Question: Summarize what this figure shows in one sentence.
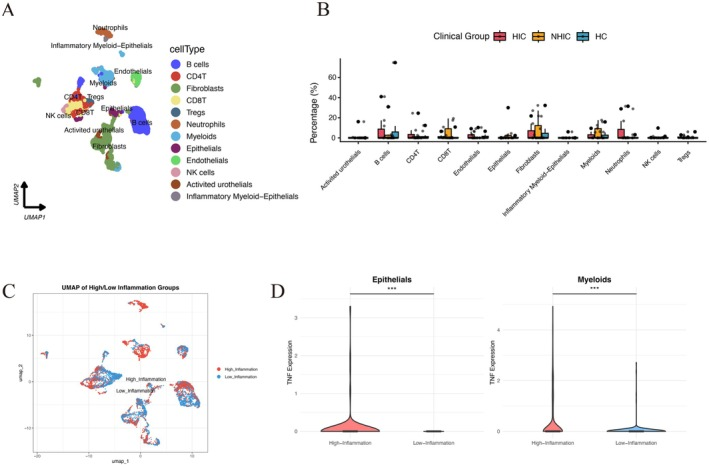
Answer: Single‐cell transcriptomic profiling of bladder tissues identifies distinct inflammatory cell states in IC/BPS. (A) UMAP visualization of bladder scRNA‐seq data, color‐annotated by 12 distinct cell types, including immune cells, stromal cells, and epithelial subsets. (B) Cell type composition analysis across three clinical groups: HIC (red), NHIC (yellow), and HC (blue), revealing differential immune cell infiltration between IC/BPS subtypes. (C) UMAP projection of all cells stratified into high‐inflammation subgroup (red) and low‐inflammation subgroup (blue) based on inflammatory gene expression signatures. (D) Violin plots showing significantly elevated TNF expression in epithelial and myeloid cells derived from the high‐inflammation subgroup.